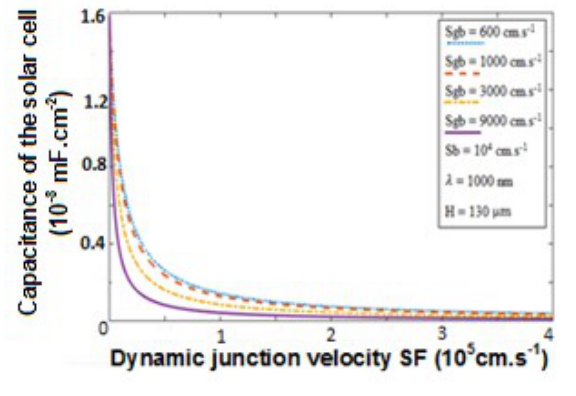
Figure 2. Capacitance of the illuminated solar cell versus SF for various Sgb: R= 0.01 cm.